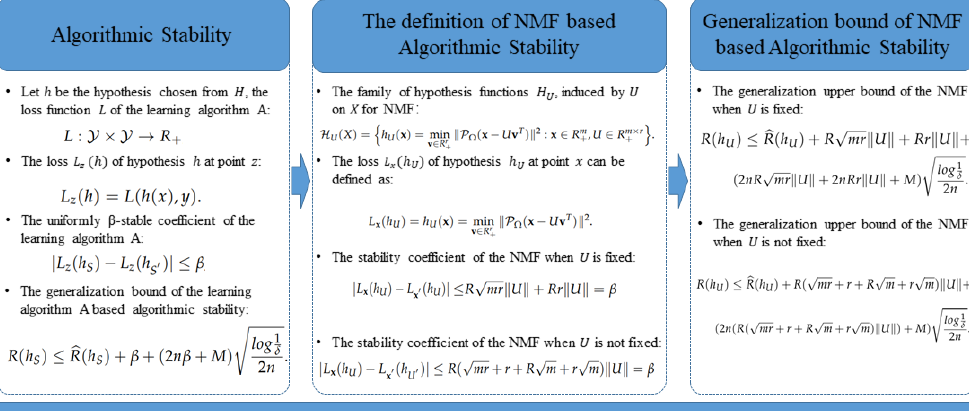
Figure 1. Overview of our AS-NMF algorithm, which consist of three parts: Algorithmic Stability, Definition of NMF based Algorithmic Stability and Generalization bound of NMF Algorithmic Stability. It defines the concept of algorithmic stability, which can analyze and measure generalization error bounds for NMF